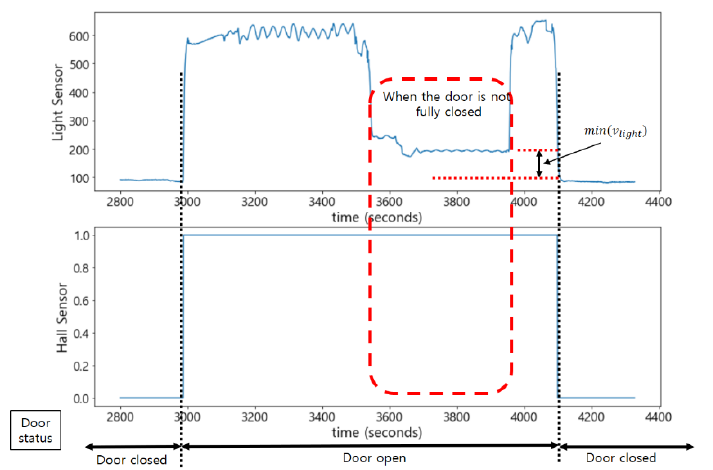
Figure 14. Determination of the status of the door with combination of the light sensor and the Hall sensor.